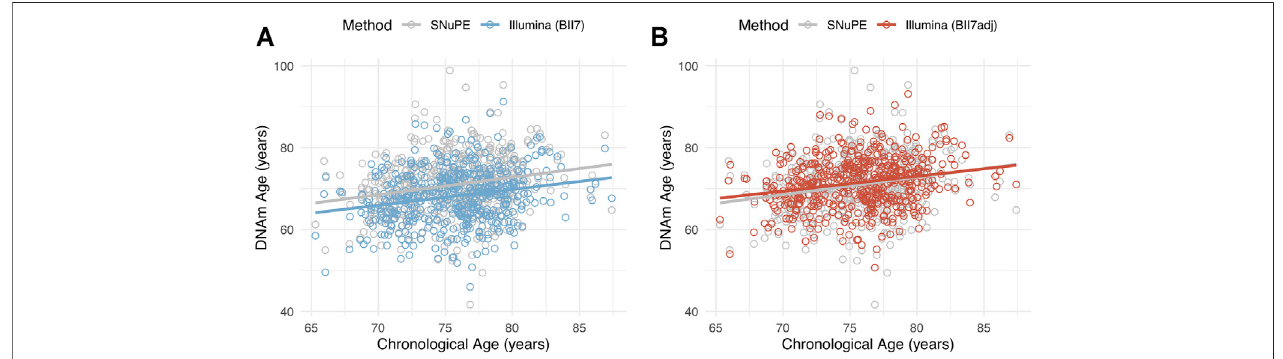
FIGURE3| Scatterplotofmethylationage,measuredwiththeSNuPE(grey)andEPICarray(Illumina)method(color)andcalculatedwiththe “ BII7 ” (A) and “ BII7adj ” formula (B) , on chronological age in the validation set ( n (cid:1)